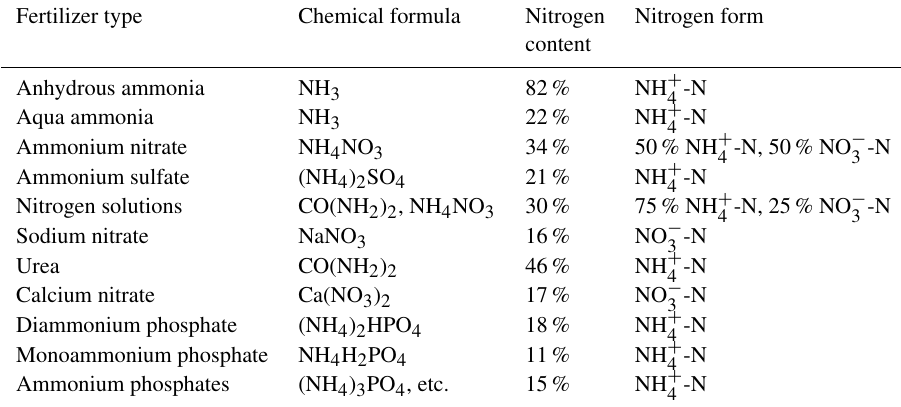
Table 2. The chemical formula, nitrogen content, and nitrogen form of 11 N fertilizer types. Ammonium phosphates (APs) are the integration of ammonium phosphate compounds in different formula. We assumed its nitrogen content is 15% from 1900 to 2015. Although one of the APs is ammonium phosphate nitrate (APN), we still considered APs to be NH + of APs